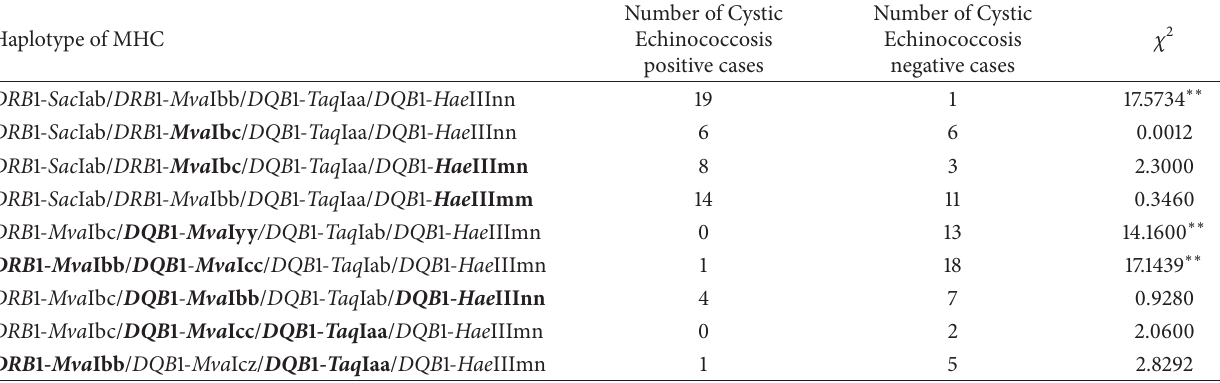
Table 3: Assessment of the relationship between haplotype and Cystic Echinococcosis in Chinese Merino sheep. Haplotype of